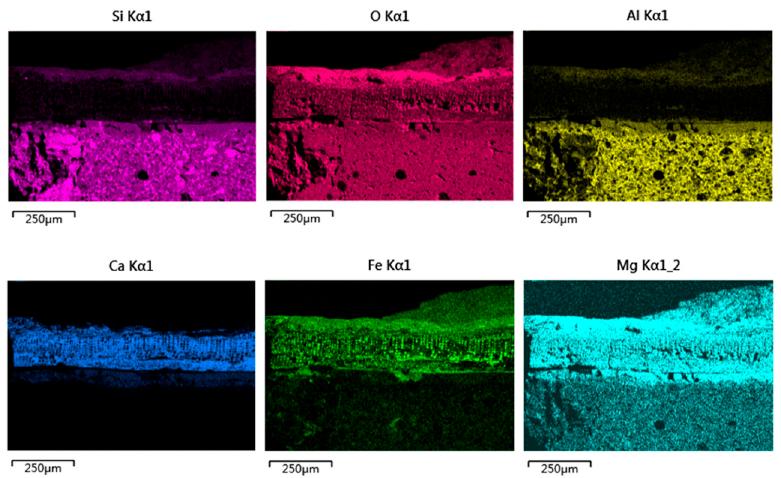
Figure 9. Element mapping images of sample DL-1 with cellular coagula attached.